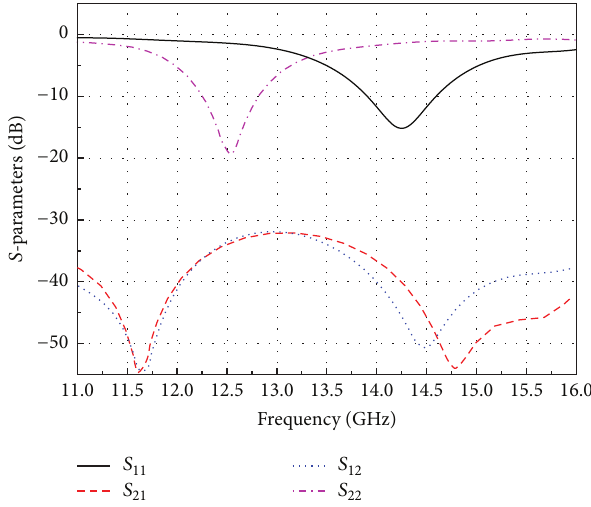
Figure 2: Simulated 𝑆 -parameters for the dual-band dual-polarized antenna